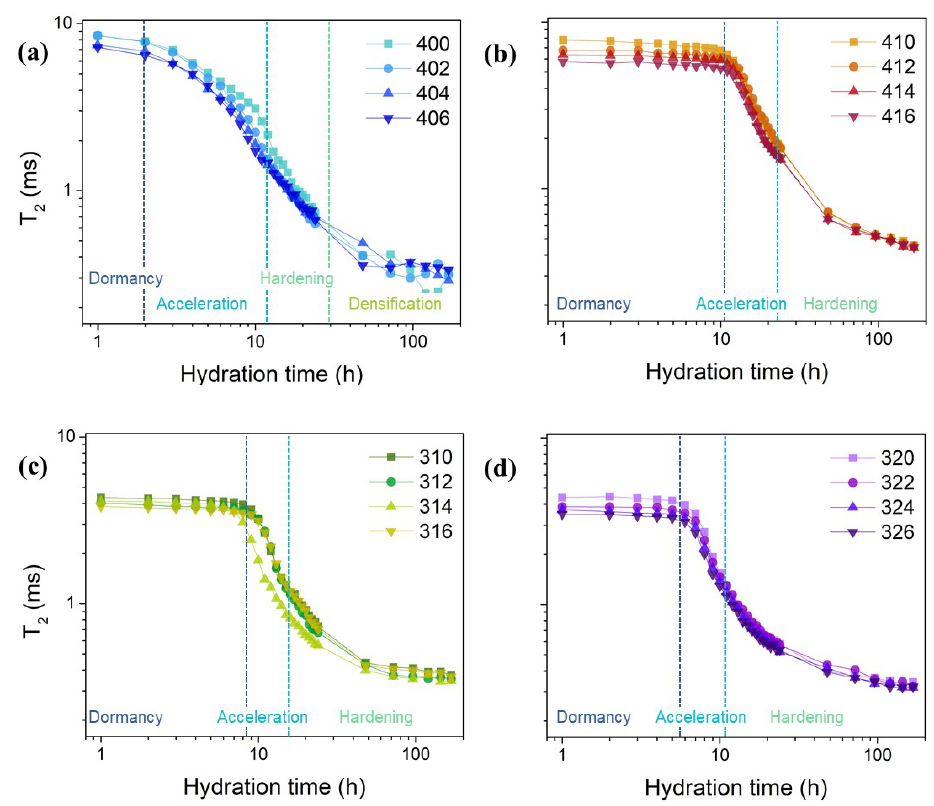
Figure 2. Evolution of the T 2 value with the maximum probability for the indicated samples: ( a ) 400–406; ( b ) 410–416; ( c ) 310–316; and, ( d ) 320–326. The different stages of hydration are outlined for each set of samples.